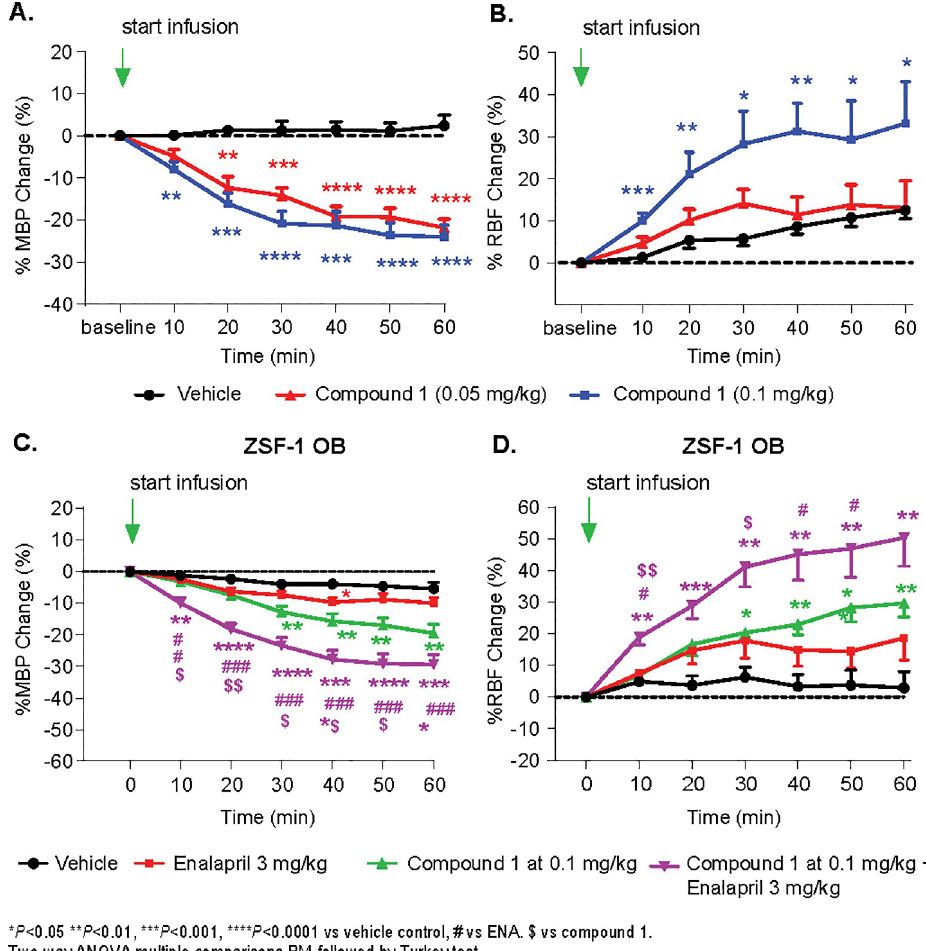
Fig 2. Acute effect of Compound 1 on MBP and RBF in anesthetized CD rats. Green arrow indicates start of IV infusion of Vehicle or Compound 1 for 30 minutes. (A) Black circle represents data from vehicle treated group; red triangle represents data from low dose of compound 1 at 0.05 mg/kg, the blue rectangle represents high dose of compound 1 at 0.1 mg/kg. Each data point represents the averaged data of MBP in a 10-min interval and shows dose- dependent effect of Compound 1 on the percentage change of MBP from baseline. In comparison with data from the Vehicle-treated group, Compound 1 significantly decreased MBP in both 0.05 and 0.1 mg/kg doses.(B) shows dose- dependent effect of Compound 1 on the percentage change of RBF. Only the high dose of Compound 1 significantly increased RBF vs Vehicle control. � P < 0.05 �� P < 0.01, ��� P < 0.001, ���� P < 0.0001 vs Vehicle control. Two-way repeated measures ANOVA with multiple comparisons followed by Tukey test. C and D. Acute effect of Compound 1 and/or Enalaprilat on MBP and RBF in anesthetized ZSF1 OB rats.